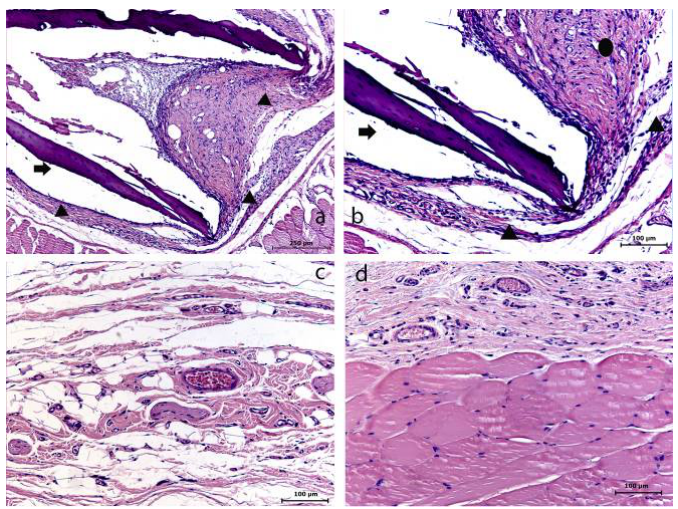
Figure 5. The control (C) group–collagen membrane at 7 ( a – b ), 15 ( c ) and 30 ( d ) days. ( a ) Evidence of the membrane (  ) and its surrounding ( ▲ ) (HE); ( b ) The presence of the membrane (  ) involved with a reactional tissue capsule ( ▲ ); inflammatory cell infiltrate (  ) (HE); ( c ) Presence of a fibroblastic/collagen characteristic tissue (  ) and no inflammatory cell infiltrate (HE); ( d ) Tissue organized